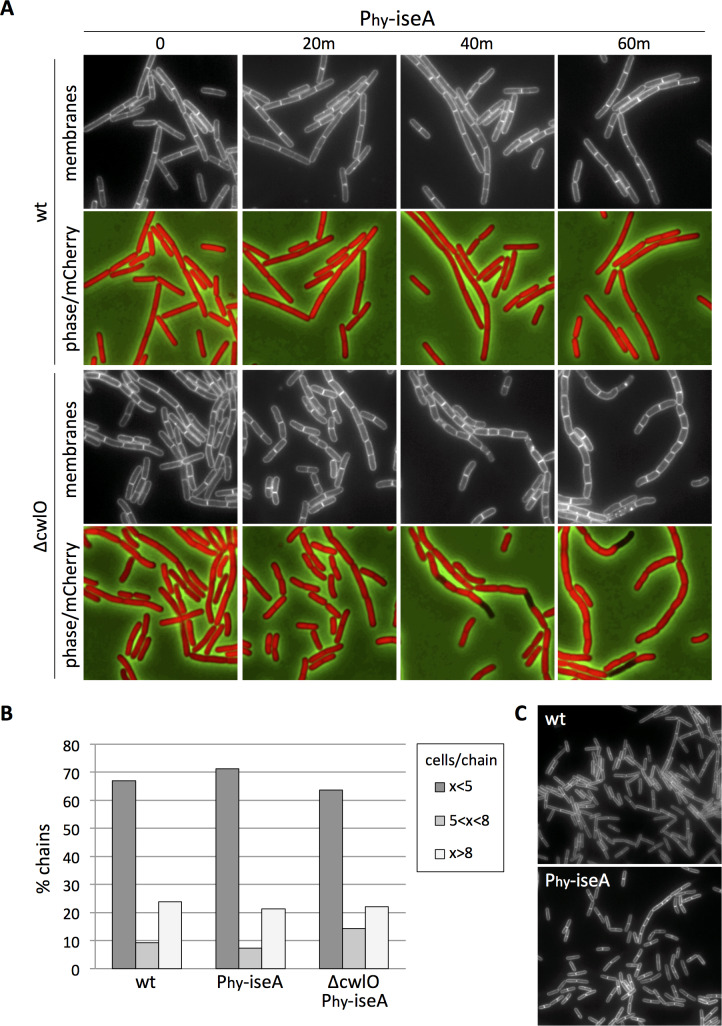
IseA inhibits LytE more potently than the cell separation hydrolases.(A) Representative images of wild-type (wt) and the ∆cwlO mutant harboring a strong IPTG-inducible promoter fused to iseA with an optimized RBS (Phy-iseA). The indicated strains also contained cytoplasmic mCherry and the membrane reporter P(xyl)-spoIVFB(E44Q)-gfp. The cells were grown to exponential phase in CH medium supplemented with 10 mM xylose and imaged before and at the indicated times after addition of 500 µM IPTG. Membranes (top) and an overlay of cytoplasmic mCherry and phase contrast (bottom) are shown. Within 20–40 min after induction of iseA, cells lacking cwlO begin to shorten and fatten indicative of a reduction in cell elongation. Scale bar indicates 2 μm. (B) Over-expression of iseA under the same conditions as in (A) has no discernable impact on cell separation. The indicated strains harboring P(xyl)-spoIVFB(E44Q)-gfp were grown in CH medium supplemented with 10 mM xylose. iseA was induced for 60 min with 500 μM IPTG and the cells were analyzed by fluorescence microscopy. Using the SpoIVFB(E44Q)-GFP membrane reporter,>1500 cells from each strain were manually classified into three groups: i) chains with fewer than 5 cells; ii) chains with 5–8 cells; iii) chains with more than 8 cells. (C) Representative images of strains imaged in (B), at the time of classification.